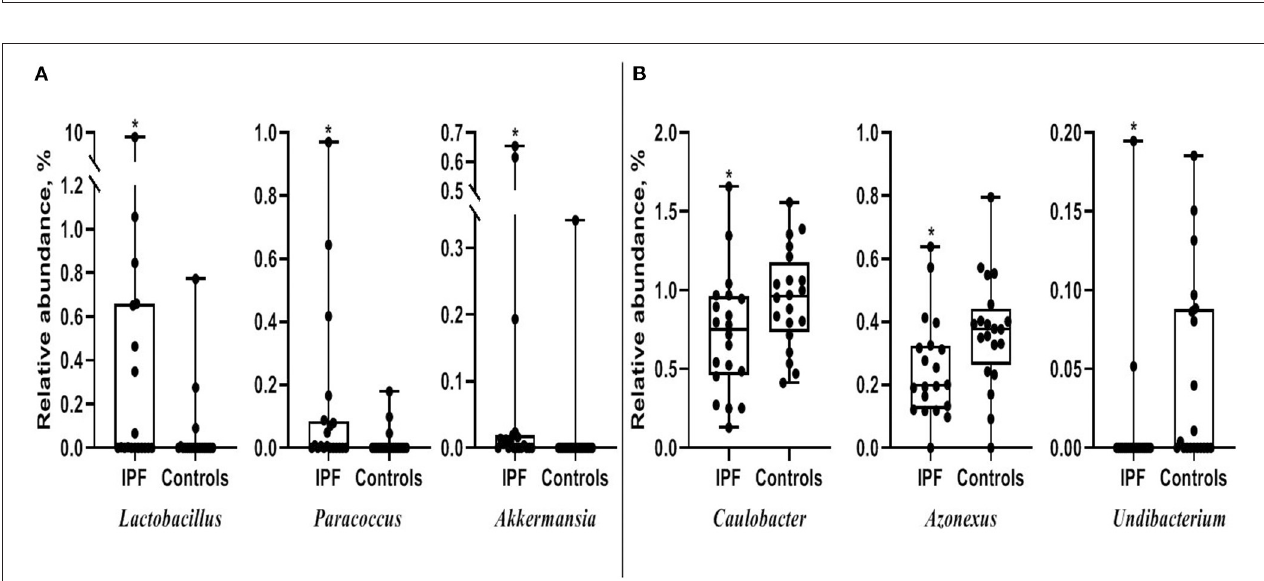
FIGURE 1 | Comparison of principal coordinates analysis using weighted UniFrac method between patients with IPF and controls. Two-dimensional PCoA plots display inter-sample distances by three principal coordinates as PC1 and PC2 (A) , PC2 and PC3 (B) , and PC1 and PC3 (C) . Each dot represents one sample, plotted by a principal component on the X -axis and another principal component on the Y -axis, and colored by the group. The ratio (%) on each axis presents the contribution of values to discrepancies among samples. IPF, idiopathic pulmonary fibrosis; PCoA, principal coordinates analysis.